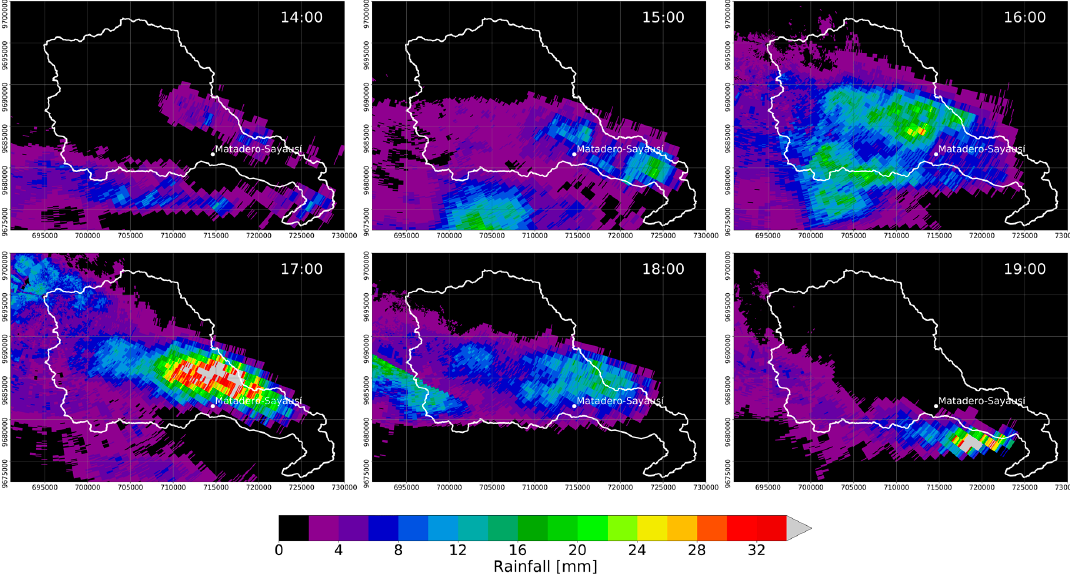
Figure 7. Hourly rainfall images from adjusted radar estimates corresponding to the rainfall event of 2017.04.13 (local time).